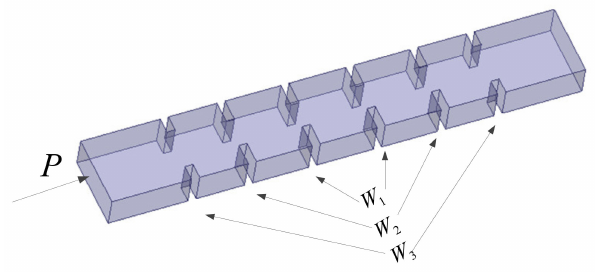
Figure 3. Structure of the iris coupled microwave cavity